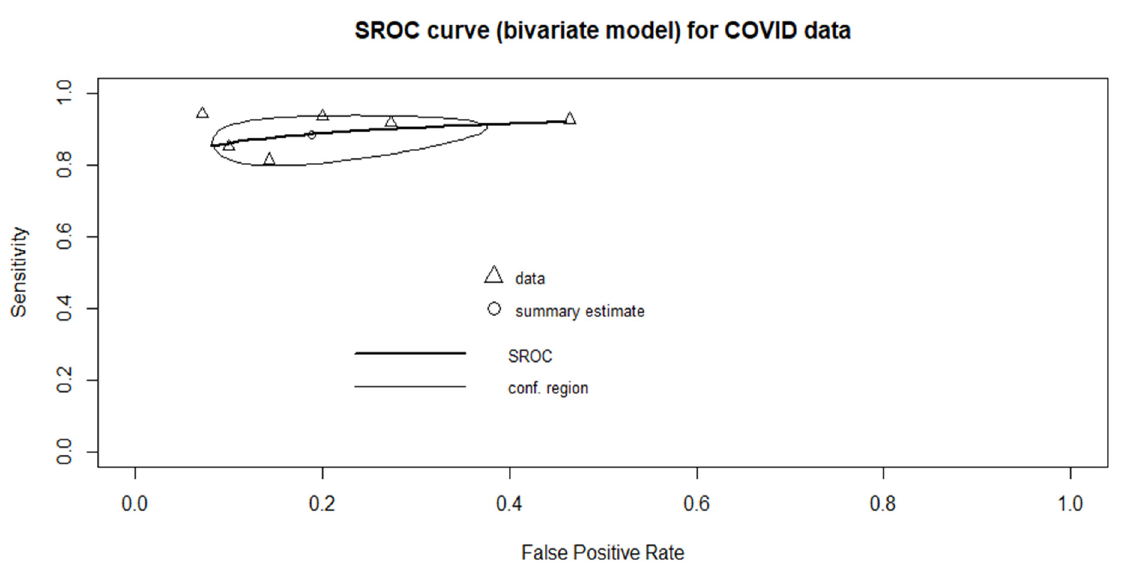
Figure 4. Summary receiver operating characteristic (sROC) curve, the AUC = 0.906.